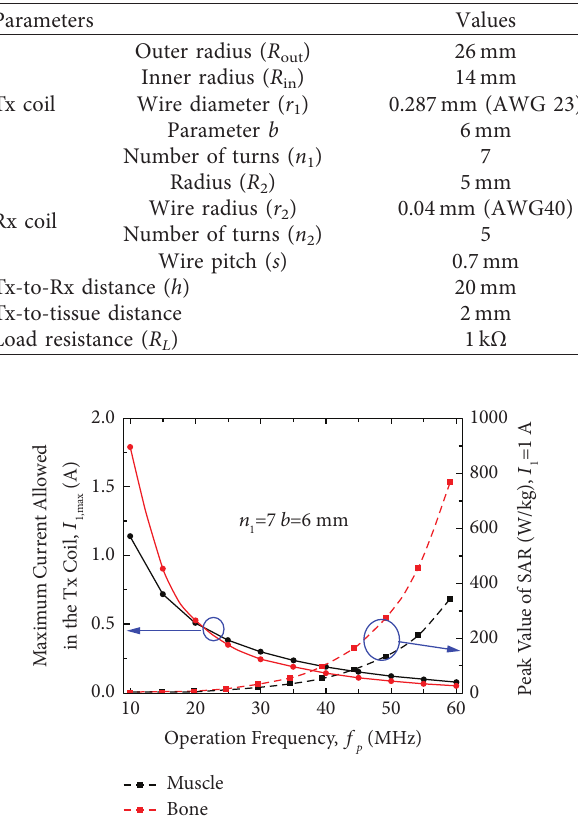
Figure 9: At Peak value of SAR at the surface of the tissue, the excitation current in the Tx coil is 1 A (left). Maximum current allowed in the Tx coil at the peak value of SAR is set to be 2 W/kg